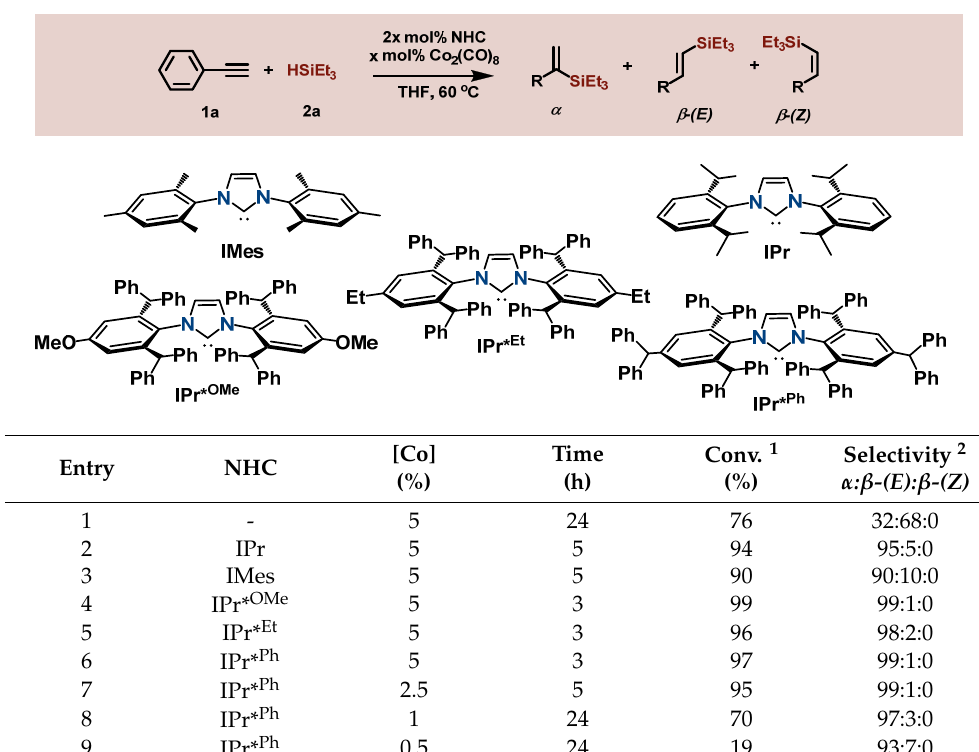
Table 1. Optimization of reaction conditions—catalyst type and amount.